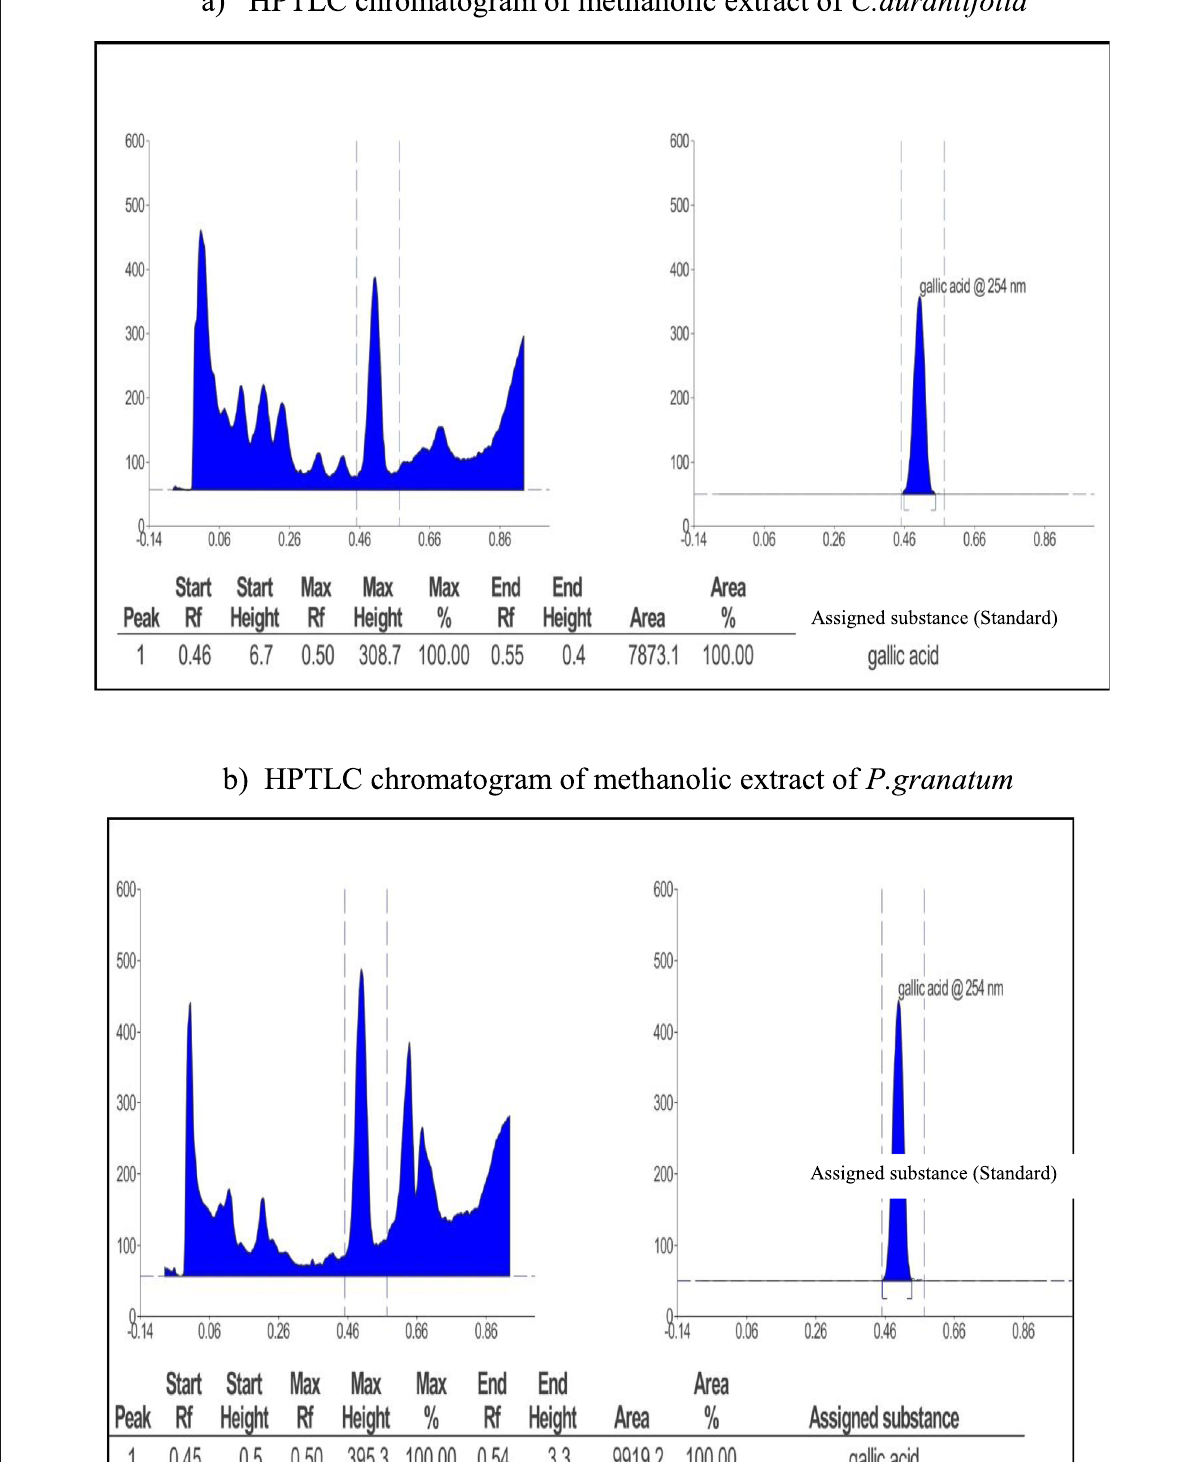
Fig. 1 a HPTLC chromatogram of methanolic extract of C.aurantifolia . b HPTLC chromatogram of methanolic extract of